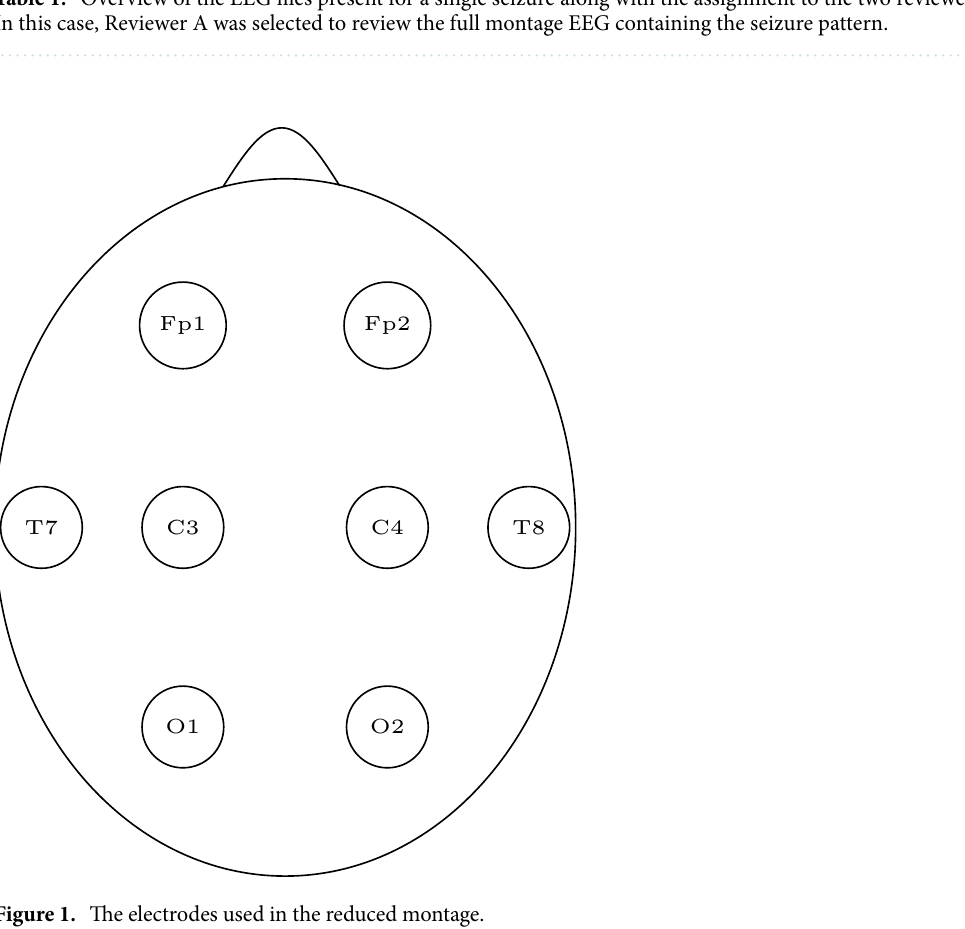
Figure 1. The electrodes used in the reduced